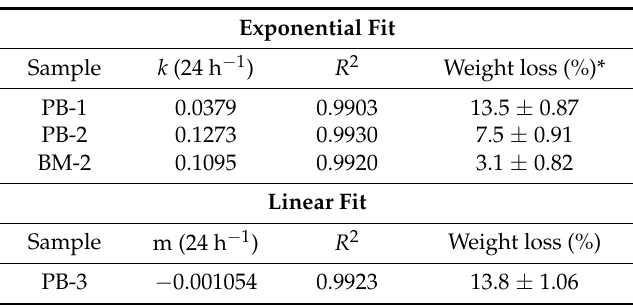
Table 1. Results of degradation rate against hydrolysis rates and percentage. *Total weight loss percentage after the elapsed 120 days of the experiment.